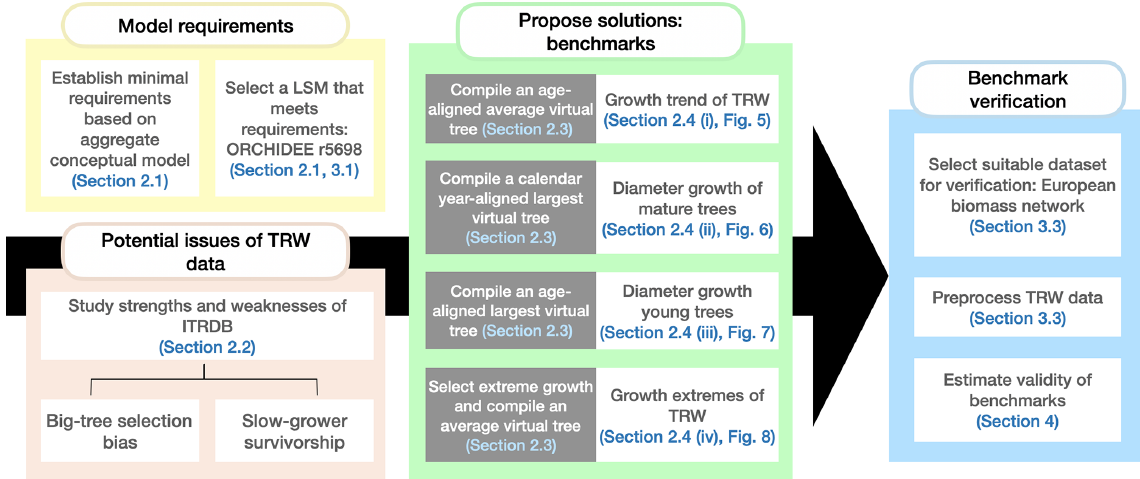
Figure 1. Workflow of this study and the dependencies between the different sections of the paper. Each colour represents a different aim of the study. The arrow shows that the outcomes of the first three aims have to be combined to verify the proposed benchmarks. In this study, “virtual tree” refers to a tree that does not exist in the data but is constructed from the data in varying ways. Section 2.3 provides detailed descriptions of the different virtual trees used.